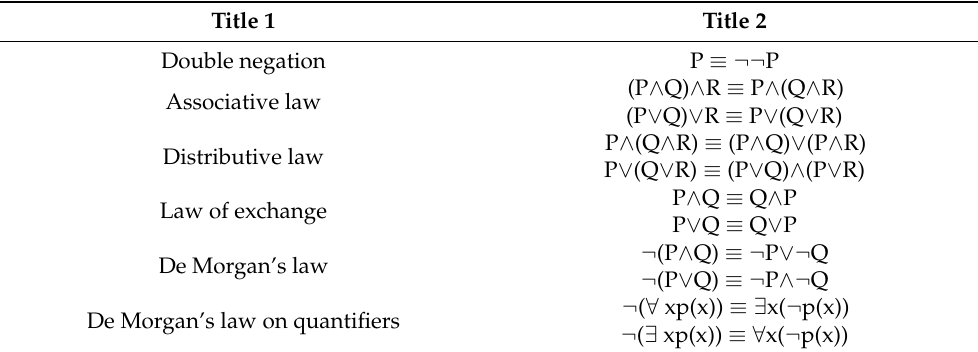
Table 2. Main equivalence relations of ethical